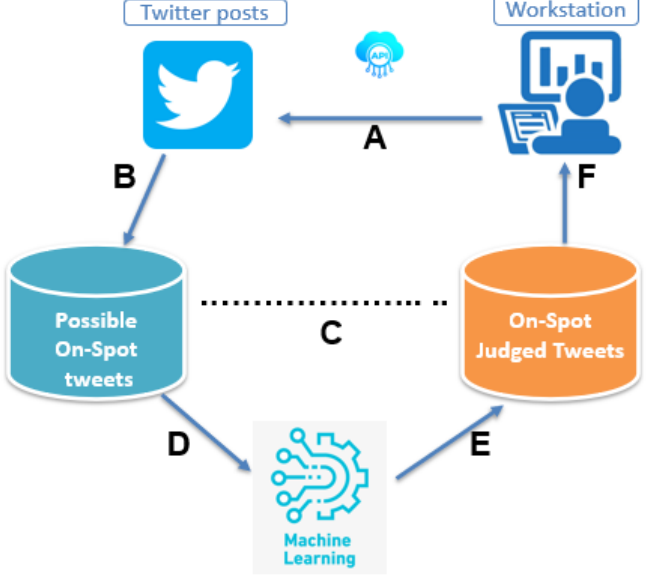
Figure 2. Outline of procedures constituting the proposed